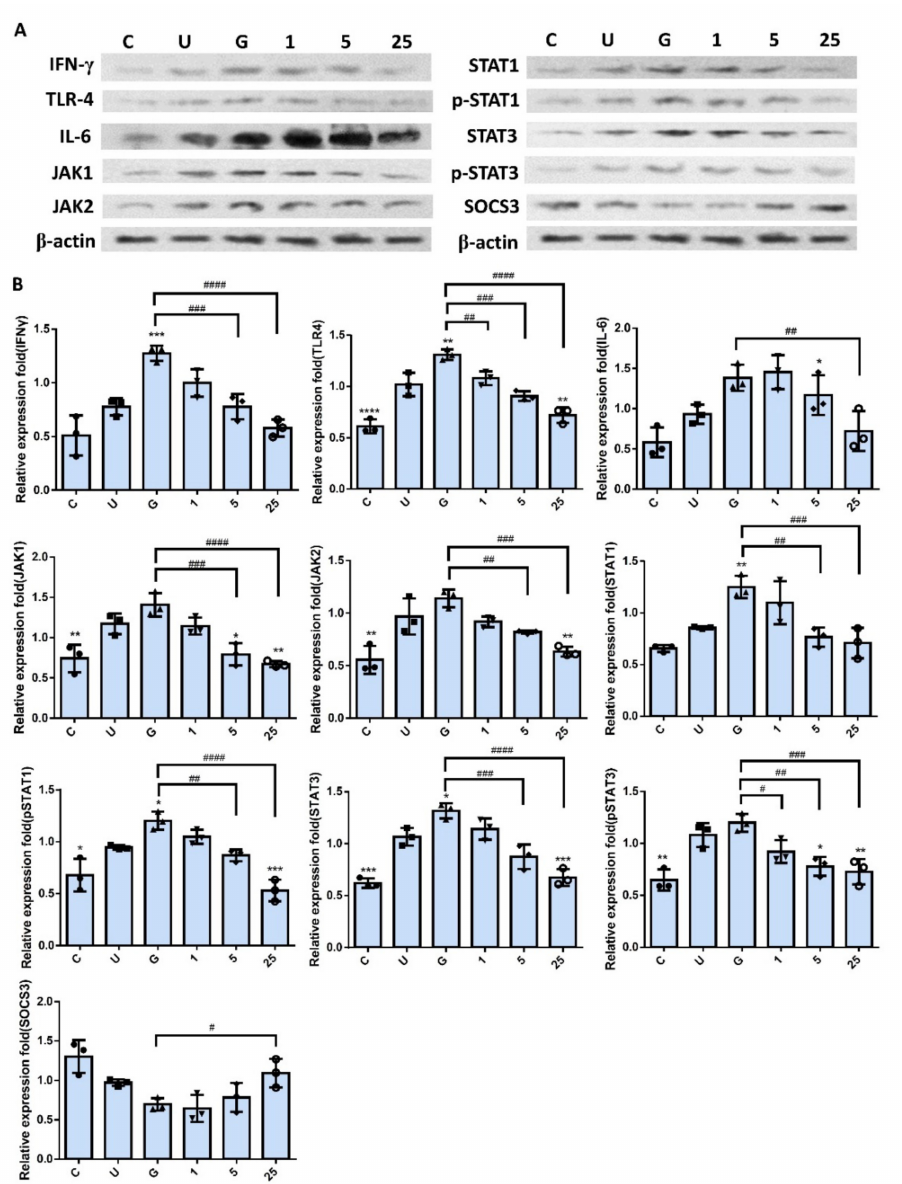
Figure 6. RNase 7 downregulated the expression of proteins associated with the JAK/STAT signaling pathway and inflammation in UPEC-infected bladder cells in a high-glucose environment. SV-HUC-1 cells were pretreated with different concentrations of RNase 7 (1, 5, and 25 µ g/mL) and 15 mM glucose for 24 h and then infected with UPEC. Total protein from all the cell groups was collected for detection. ( A ) Total protein expression of JAK1, JAK2, STAT1, STAT3, phosphorylated-STAT1/STAT3, and the inhibitor, SOCS3, TLR4, IL-6, and IFN- γ were analyzed using Western blotting. ( B ) All data were normalized to the internal reference β -actin. Results were assessed using a densitometer and quanti- fied using ImageJ software (NIH). The definitions of each letter/number represented by the X axis are: C: control; U: UPEC infection alone; G: with 15 mM glucose pretreatment alone; 1, 5, and 25: pre- treated with 1, 5, and 25 µ g/mL RNase 7, respectively, +15 mM glucose. The results are presented as mean ± SD of three independent experiments. * p < 0.05, ** p < 0.01, *** p < 0.001, **** p < 0.0001, com- pared to the respective positive control group (U). # p < 0.05, ## p < 0.01, ### p < 0.001, #### p < 0.0001, compared between the two